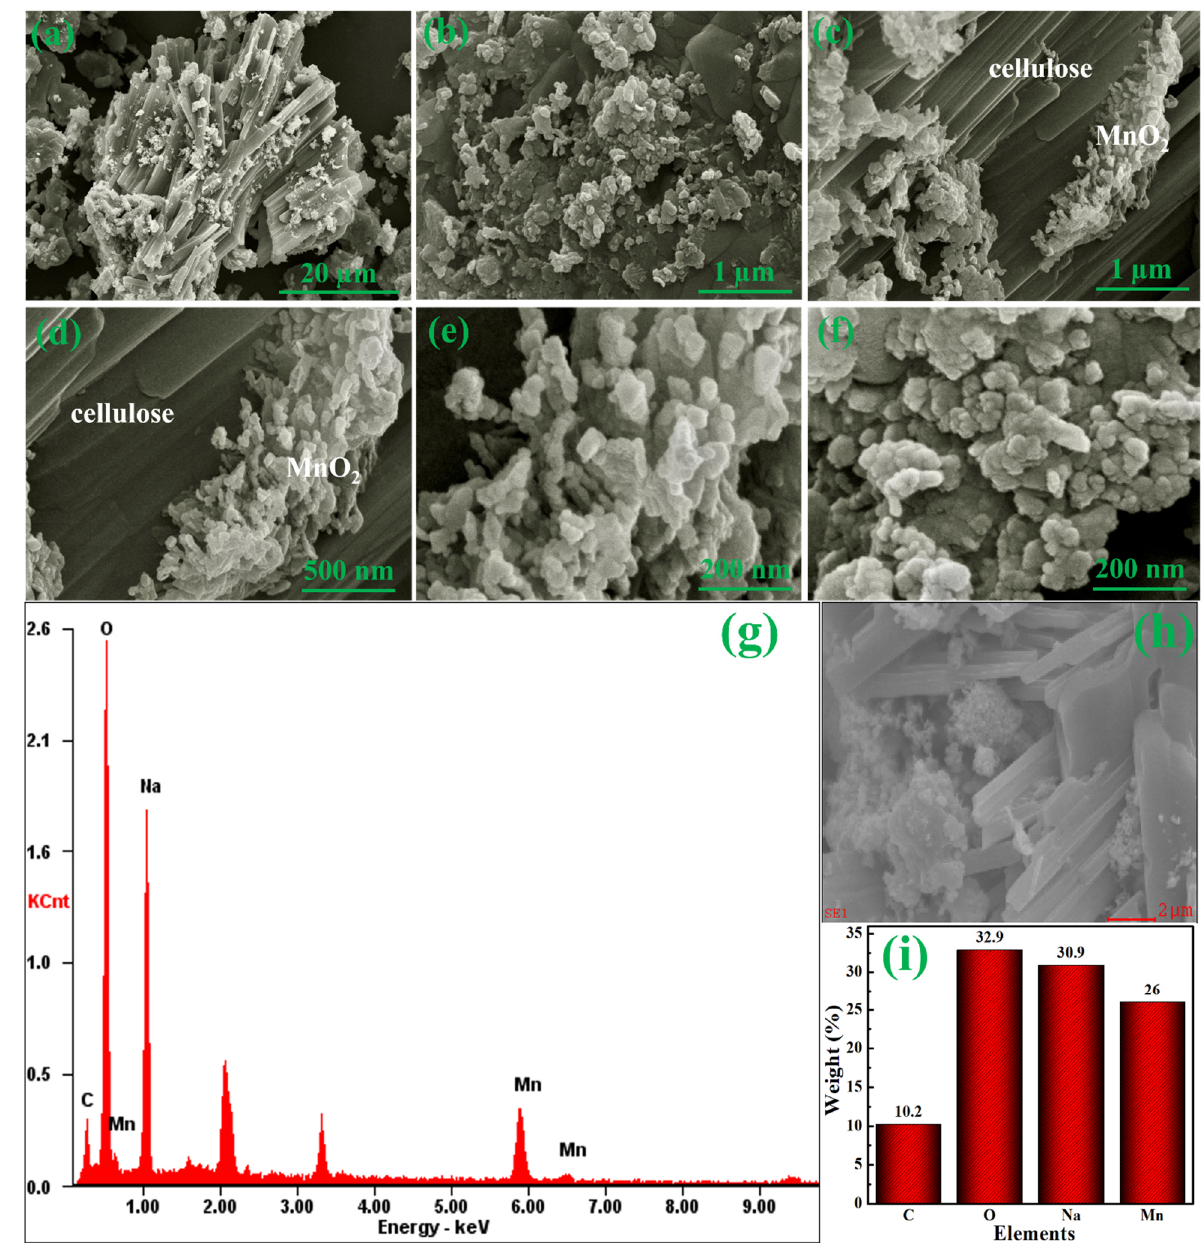
Figure 7. FE-SEM images of MnO 2 @CE at the magnification of ( a ) 20 µ m, ( b ) 1 µ m, ( c ) 1 µ m, ( d ) 500 nm, ( e ) 200 nm, ( f ) 200 nm, and ( g – i ) EDAX profile with elemental percentage by